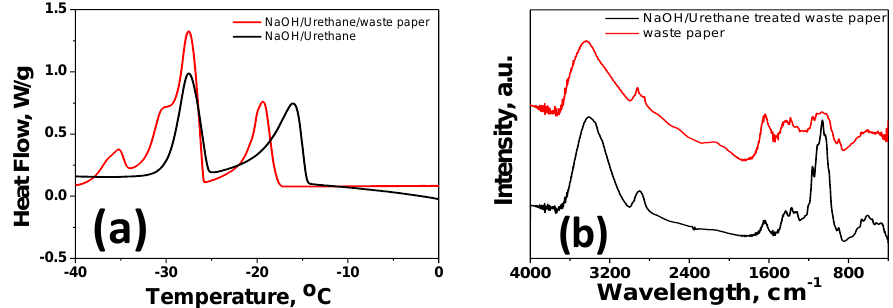
Figure2. Di ff erentialscanningcalorimetry(DSC)( a )andFourier-transforminfrared(FTIR)spectroscopy Figure 2. Differential scanning calorimetry (DSC) (a) and Fourier-transform infrared (FTIR) ( b ) spectra of microfibrillar cellulose extracted by NaOH / urethane / waste paper and waste spectroscopy (b) spectra of microfibrillar cellulose extracted by NaOH/urethane/waste paper and waste paper.